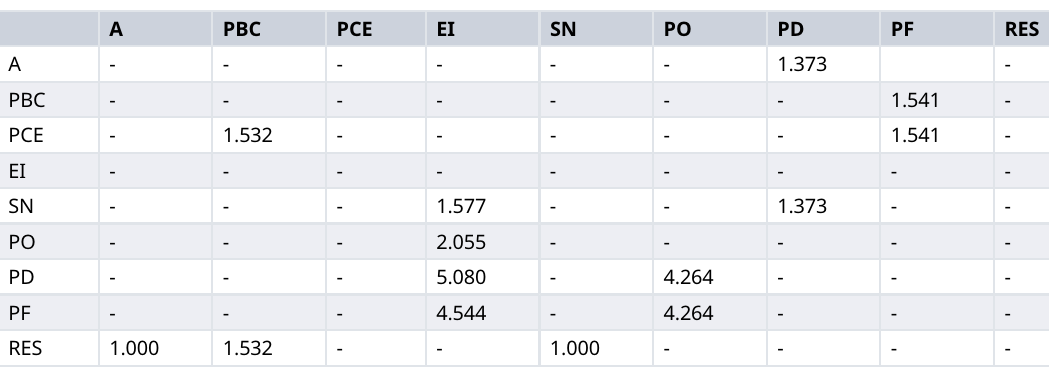
Table 3. Collinearity Variance Inflaction Factor (VIFs).